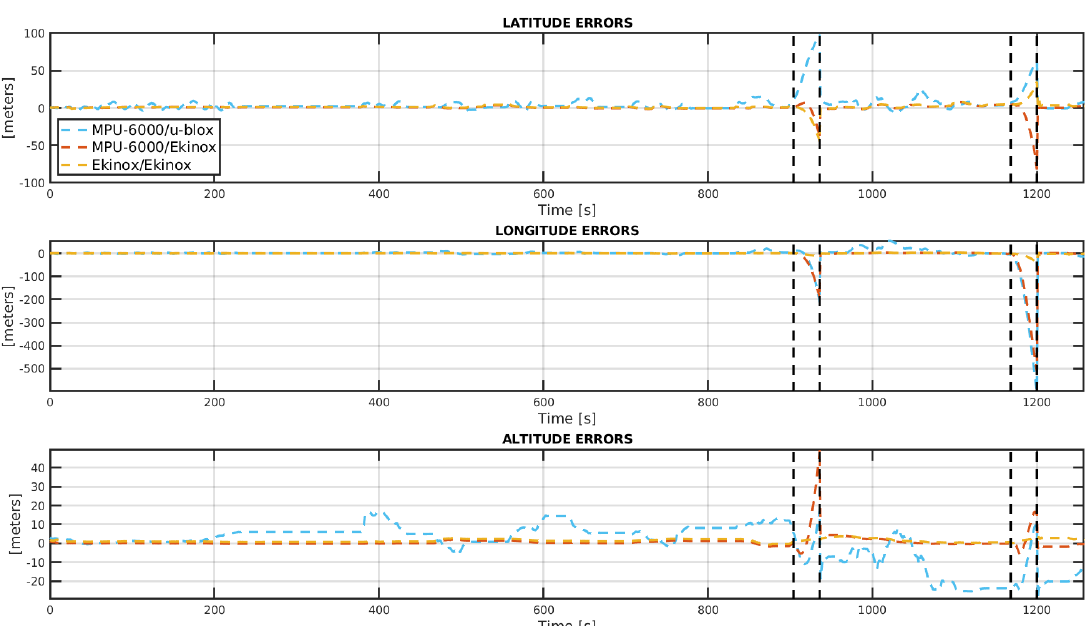
Figure 10. Position errors for the complete trajectory. Black vertical lines spot both GNSS-denied